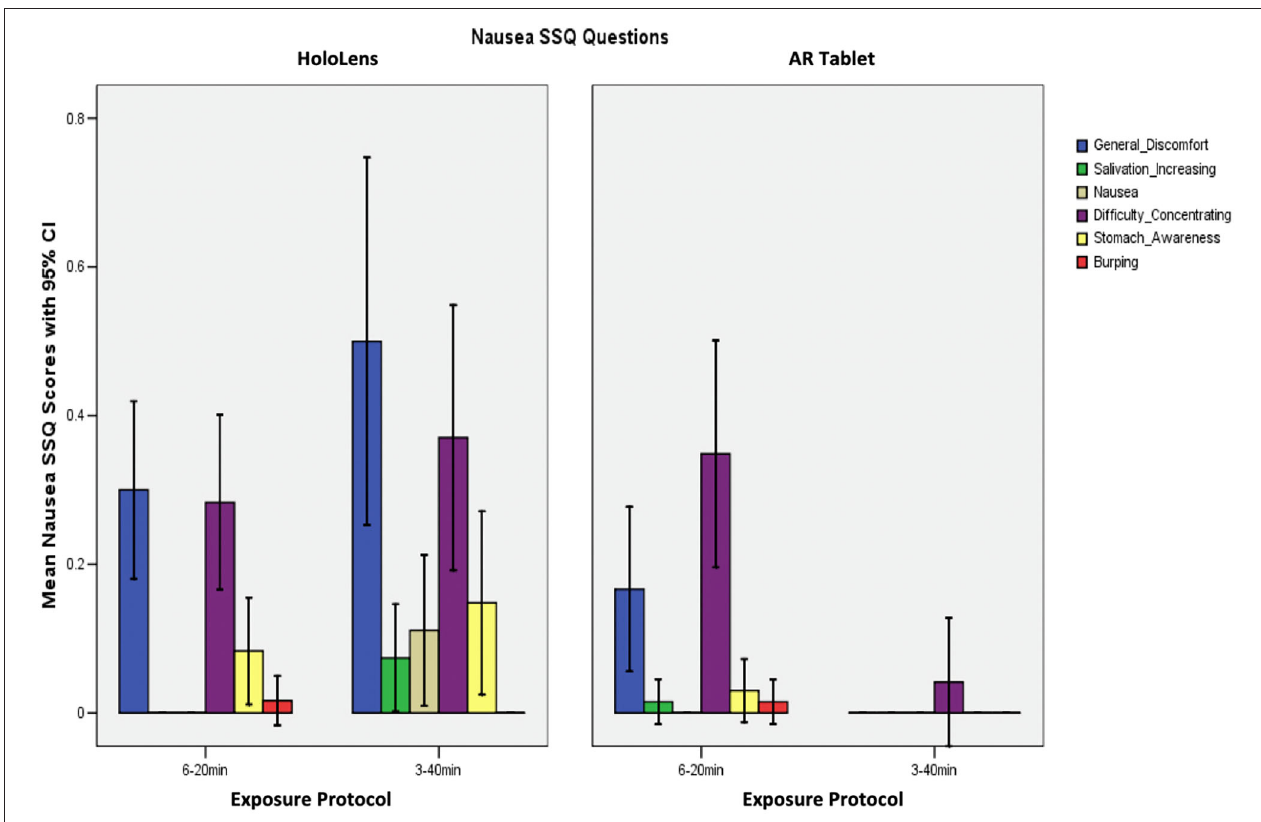
FIGURE 5 | Mean nausea SSQ question scores with 95% CI.